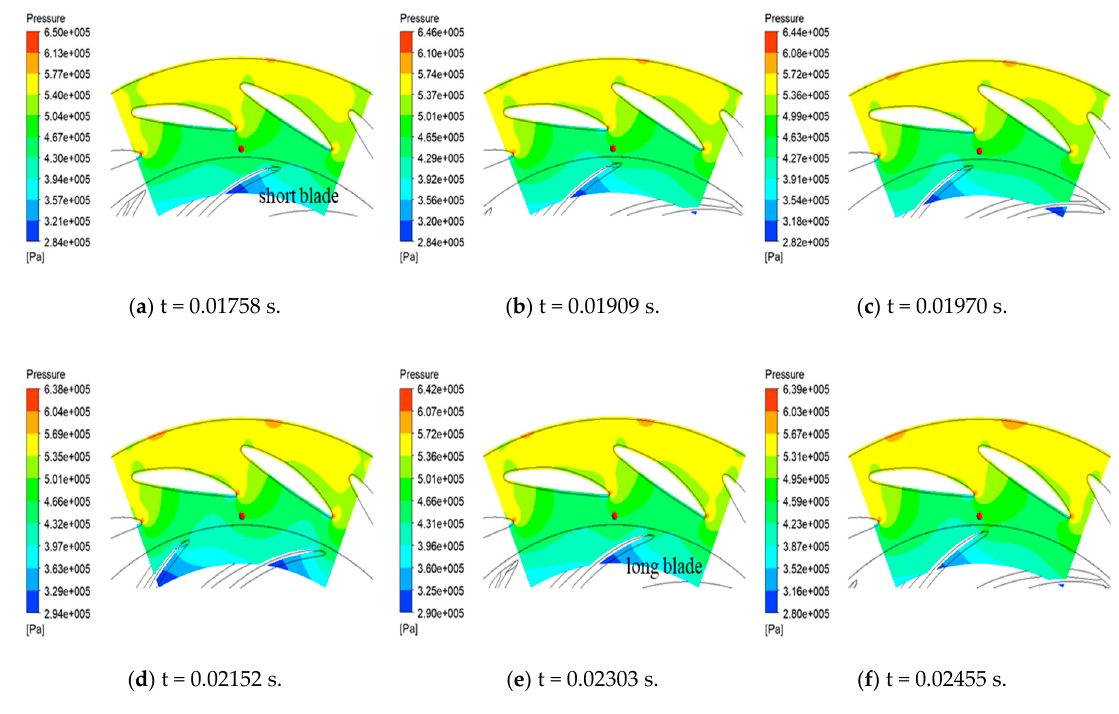
ff erent times at 1.0 Q d